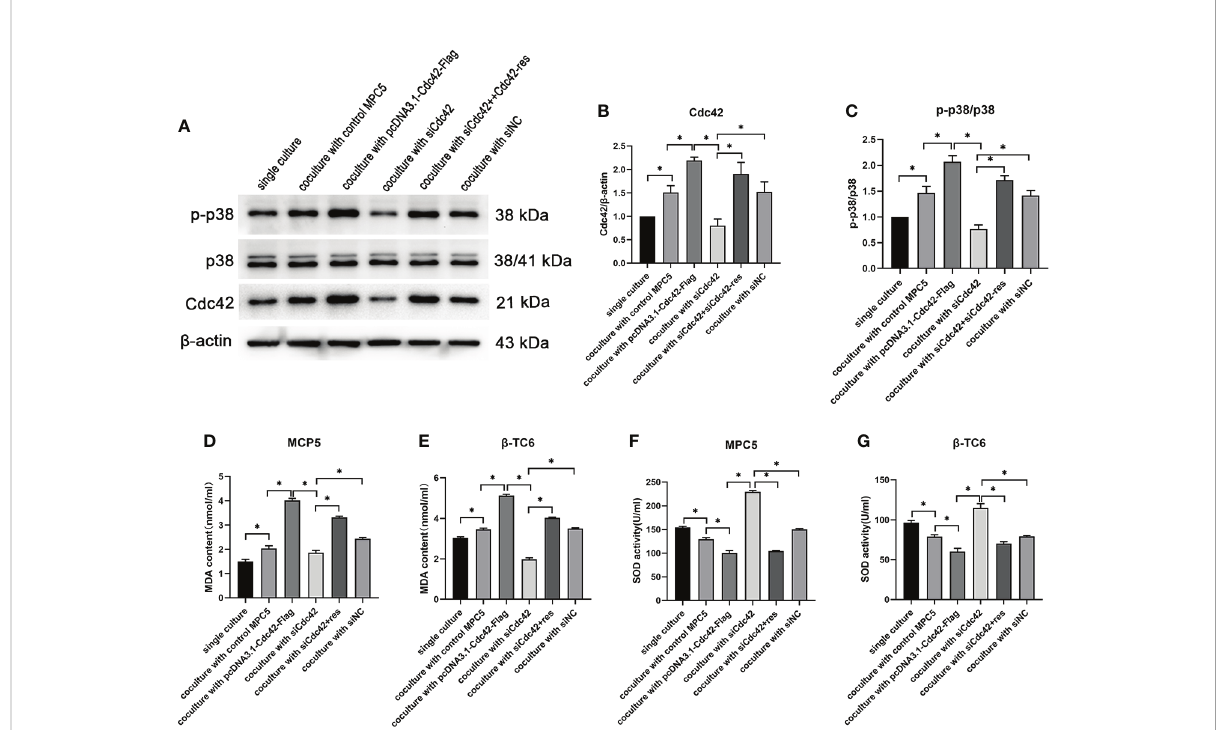
FIGURE 6 The upregulation of Cdc42 in podocytes increased the Cdc42 expression and the p-p38/p38 ratio in b -TC6 cells, which were accompanied by an increase in malondialdehyde (MDA) levels and a decrease in SOD activity. ( A – C ) The protein expression levels of Cdc42, p-38, and p-p38 in b -TC6 cells were detected. ( D – G ) The levels of MDA and SOD in MPC5 cells and b -TC6 cells were measured. Data are presented as mean ± SEM; * P <